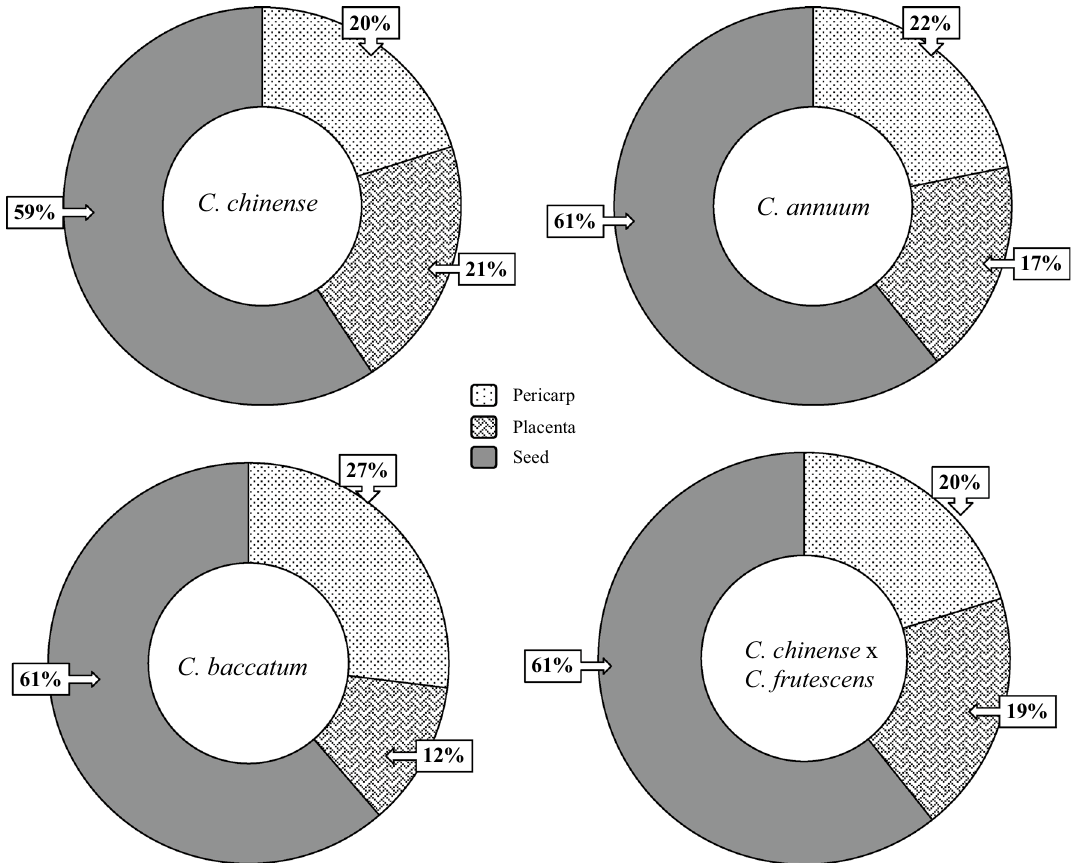
Figure 1. Average dry weight ratio among pericarp, placenta and seed in four different species of